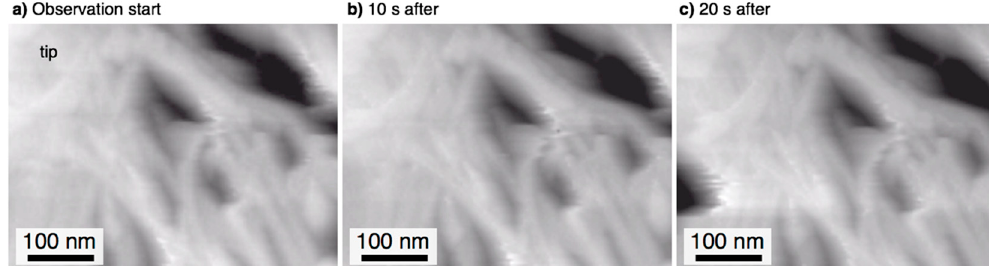
Figure 4. In situ HS-AFM (high-speed atomic force microscopy) images of the pyramidal bundle structure consisting of anodic alumina nanofibers in ultrapure water: ( a ) when observation starts, ( b )